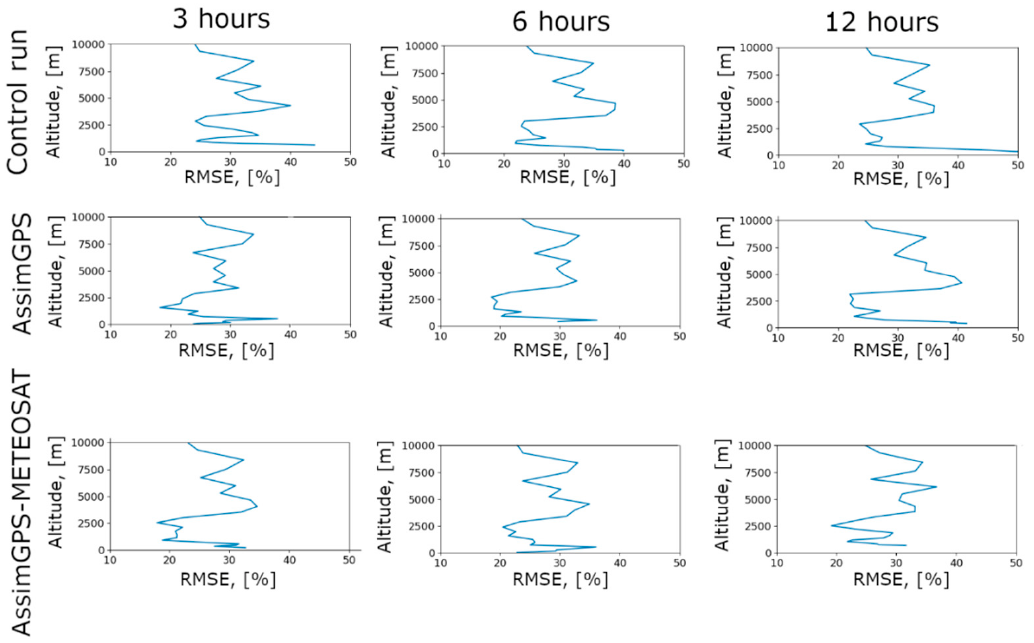
Figure 9. Vertical profile of RMSE of RH for the different types of runs and lead times.